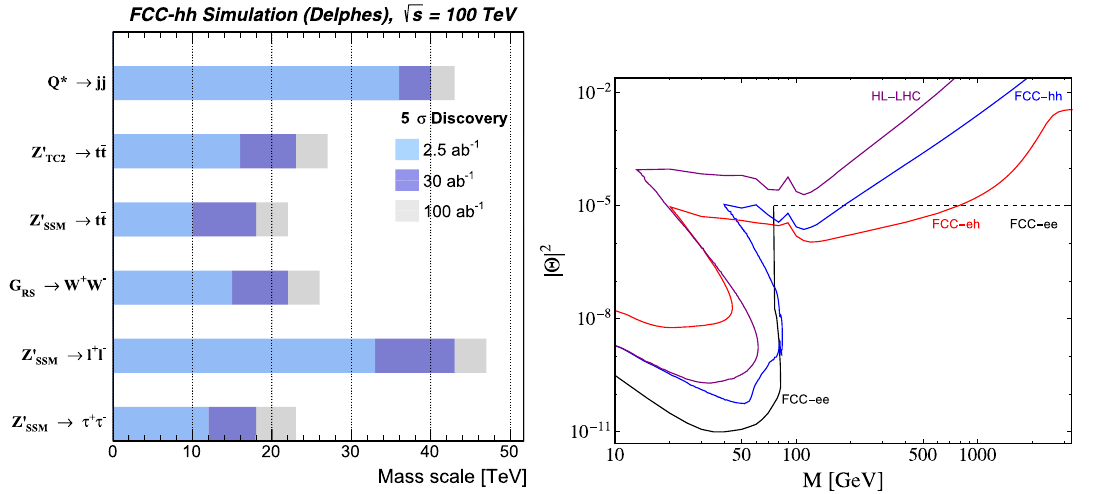
Fig. S.5 Left: FCC-hh mass reach for different s-channel resonances. Right:summaryofheavysterileneutrinodiscoveryprospectsatallFCC facilities. Solid lines are shown for direct searches at FCC-ee (black, in